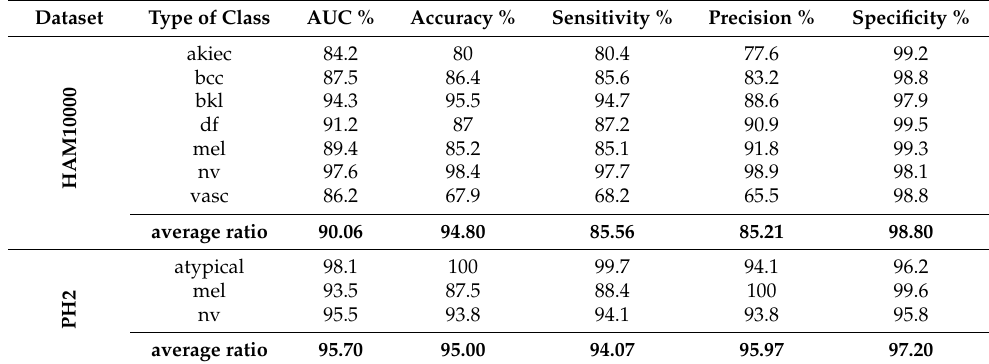
Table 6. Performance of SVM with ResNet101 features for dermoscopic image analysis to classify HAM10000 and PH2 dataset skin